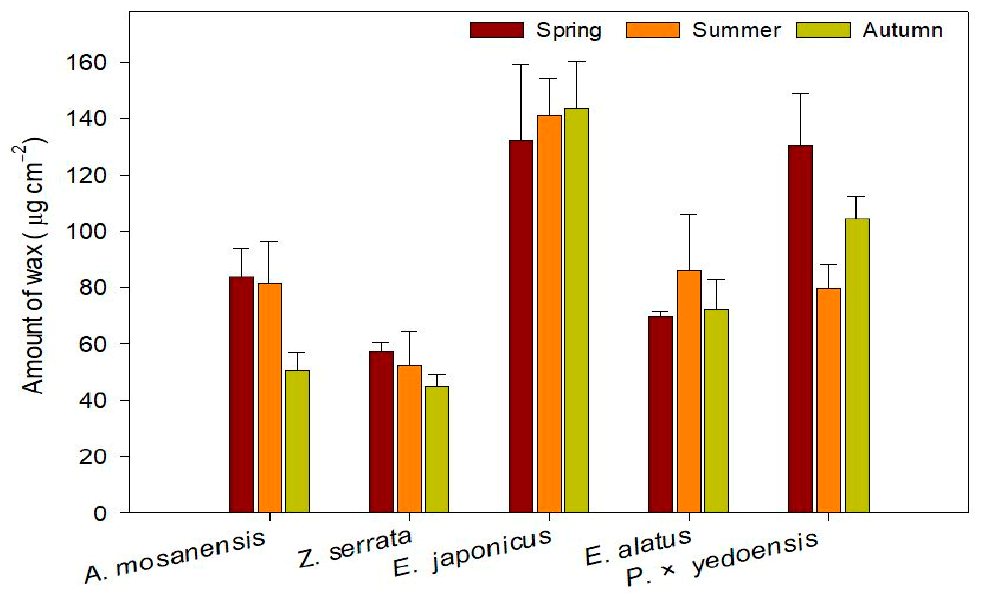
Figure 3. The amount of epicuticular wax of five plant species in three seasons (spring, summer and autumn).